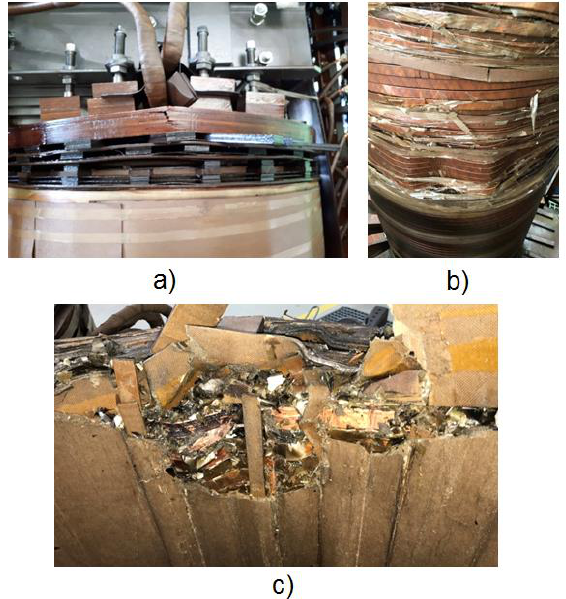
Figure 4. The damages identified during the internal inspection of 30 MVA, 110 / 10.5 kV step-up generator transformer. ( a ) Loose and damaged clamping elements, ( b ) turn short circuits in primary (high voltage) windings, and ( c ) traces from the electric arc (acting the electro-dynamic forces) in the secondary windings.